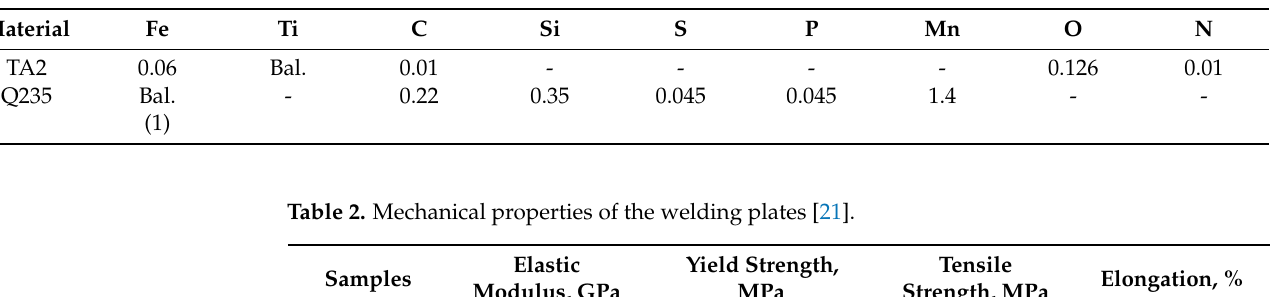
Table 1. Chemical composition of the welding materials. (Mass fraction, %) [20].